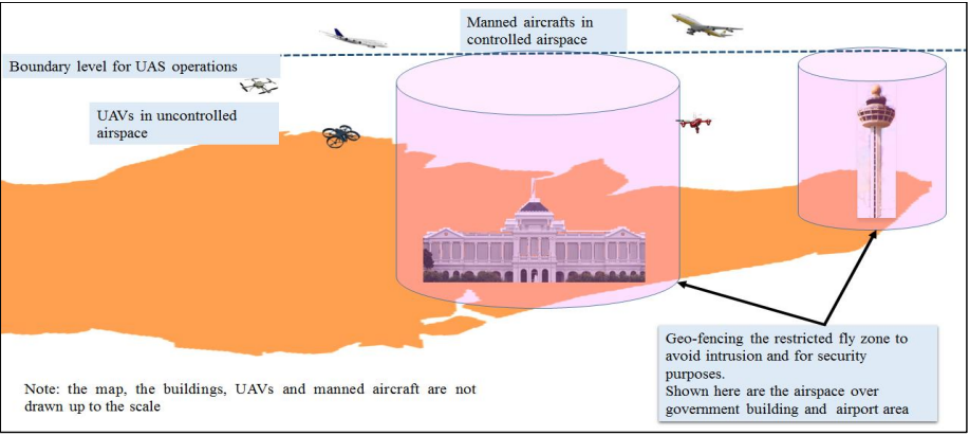
Figure 3. Geo-fencing of critical airspace (Pathiyil et al.